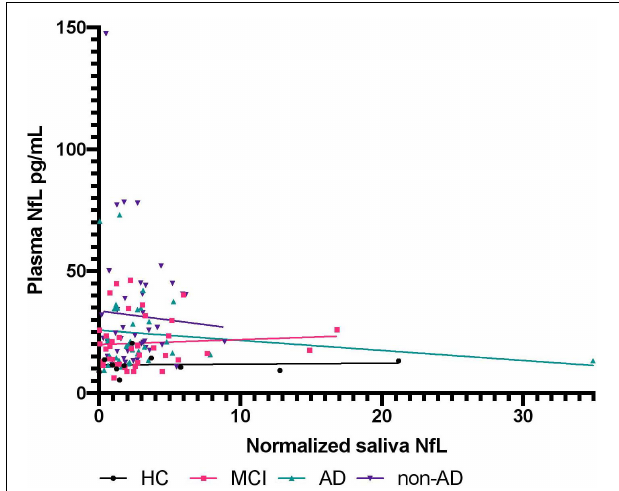
FIGURE 2 | The association between neurofilament light chain in plasma and normalized salivary neurofilament light chain. The figure shows the relationship between NfL in plasma and normalized NfL in saliva for HC, MCI, AD, and non-AD. NIL, neurofilament light chain; HC, healthy controls; MCI, mild cognitive impairment; AD, Alzheimer’s